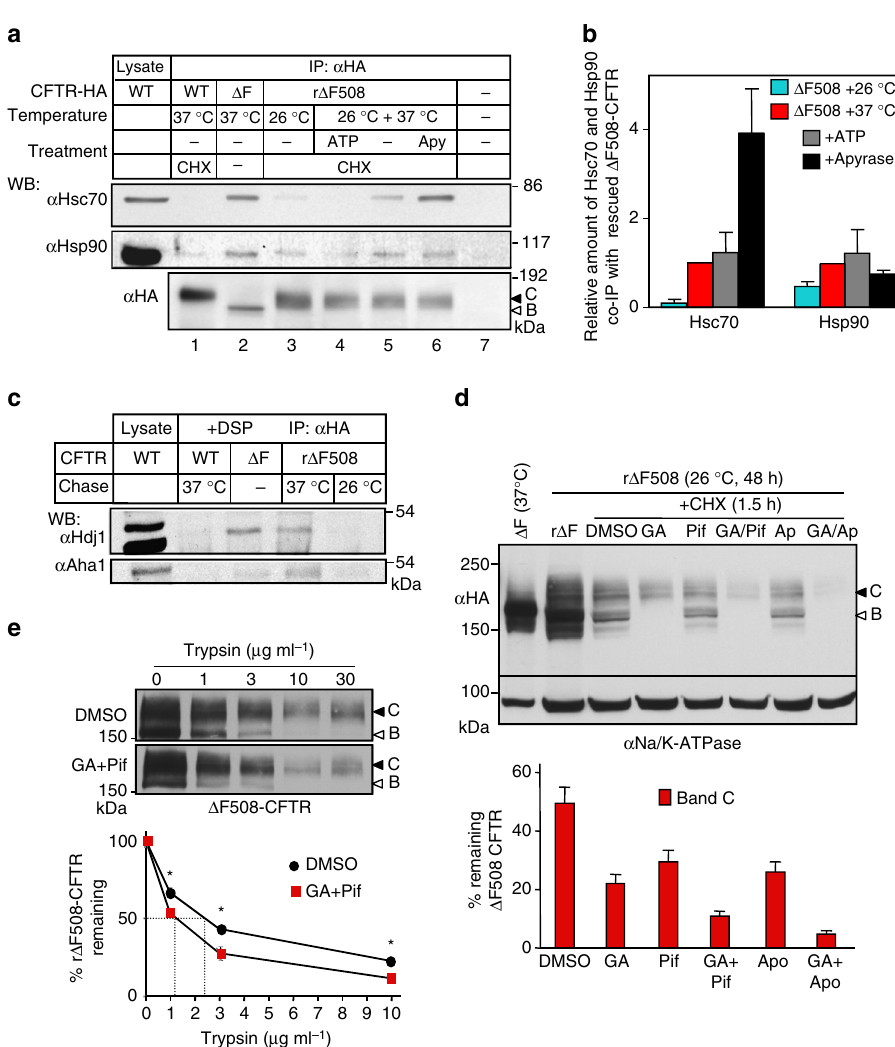
Fig. 1 Molecular chaperone activity maintains the limited transport competence of Δ F508- and P67L-CFTR. a Hsc70 and Hsp90 association with WT- and Δ F508-CFTR containing a C-terminal HA-tag in BHK-21 cells by co-immunoprecipitation (Co-IP) and immunoblotting. Low-temperature rescued Δ F508- CFTR (r Δ F508-CFTR, 24 h, 26 °C, lanes 3 – 6), the channel was either unfolded for 2.5 h at 37 °C in the presence of 150 μ g ml − 1 cycloheximide (CHX) ( lanes 4 – 6) or exposed to 37 °C for 20 min and then cultured at 26 °C for 12 h with CHX. The latter protocol preserved the near-native conformation of the complex-glycosylated form (band C, fi lled arrowhead ), while ensured degradation of the core-glycosylated form (band B, empty arrowhead , lane 3). WT- CFTR cells were exposed to CHX (2.5 h, 37 °C, lane 1). CFTR was IP with anti-HA antibody in the absence or presence of 2 mM ATP plus 1 mM MgCl 2 ( + ATP) or with 150 U ml − 1 Apyrase ( + Apy) and the IP was probed for Hsc70/Hsp90. Parental ( lane 7) and non-rescued Δ F508-CFTR ( lane 2) BHK-21 cells served as controls. b Hsc70 or Hsp90 fold-association with the complex-glycosylated r Δ F508-CFTR was expressed relative to that observed after unfolding 37 °C for 2.5 h. Data are means ± standard error of the mean (SEM), n = 3 – 4. c Co-IP of co-chaperones with CFTR after crosslinking with 0.1 mM dithiobis[succinimidyl propionate] (DSP) was performed after exposing the cells to CHX chase (2.5 h, at 26 or 37 °C) as described for a . d The effect of Hsp70/Hsp90 inhibitors on the r Δ F508-CFTR turnover, measured by quantitative immunoblotting. Rescued Δ F508-CFTR (26 °C, 48 h) was unfolded for 1.5 h at 37 °C in the absence or presence of Hsc70 (1 μ M pifthrin μ [Pif] or 1 μ M apoptozole [Apo]) or Hsp90 (10 μ g ml − 1 GA) inhibitor plus 150 μ g ml − 1 CHX. Na + /K + -ATPase served as loading control. Densitometric analysis of r Δ F508-CFTR band C remaining after 1.5 h CHX chase. Data are means ± SEM, n = 3 – 4. e Limited trypsinolysis of Δ F508-CFTR in microsomes. Microsomes were isolated from BHK-21 cells that were exposed to DMSO or 5 μ M Pif and 5 μ g ml α GA (2 h, 37 °C) as described in Methods. Remaining complex-glycosylated r Δ F508-CFTR was expressed as the percentage of the initial amount ( bottom panel ). Means ± SEM, n = 3 –